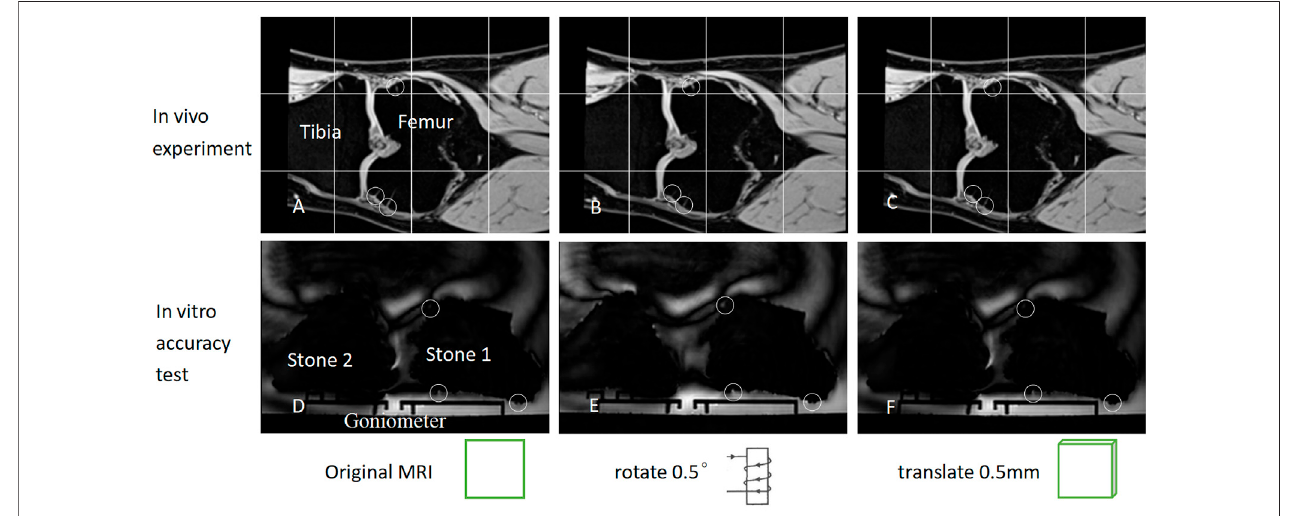
FIGURE3|(A) depictsthecoronalMRIoftheknee jointpriortorotation/displacement. ItshouldbenotedthattheSCVSismarkedwithsmallcircles. (B) illustrates the coronal planeimage following rotating (A) inthe sagittal plane by0.5 ° .Itshould benotedthat theSCVS has altered. (C) depicts theimage obtained bydisplacing (A) by 0.5 mm perpendicular to the coronal plane. It should be noted that the SCVS also alters. As long as one characteristic area (SCVS/surface indentation) is different, it canbedetermined thattherigidbodyhaseitherundergone aslightrotationoraslighttranslation. (D – F) issimilarto (A – C) ,except thatthetibiaand femurchanged into aquarium stones. A rotation of 0.5 ° or a displacement of 0.5 mm can, therefore, alter the characteristic area signi fi